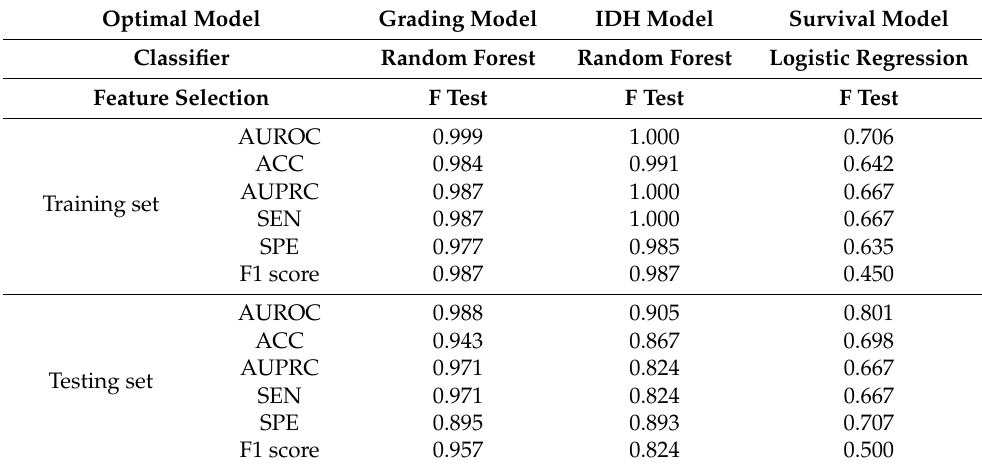
Table 2. Prediction performance of grading, IDH and survival